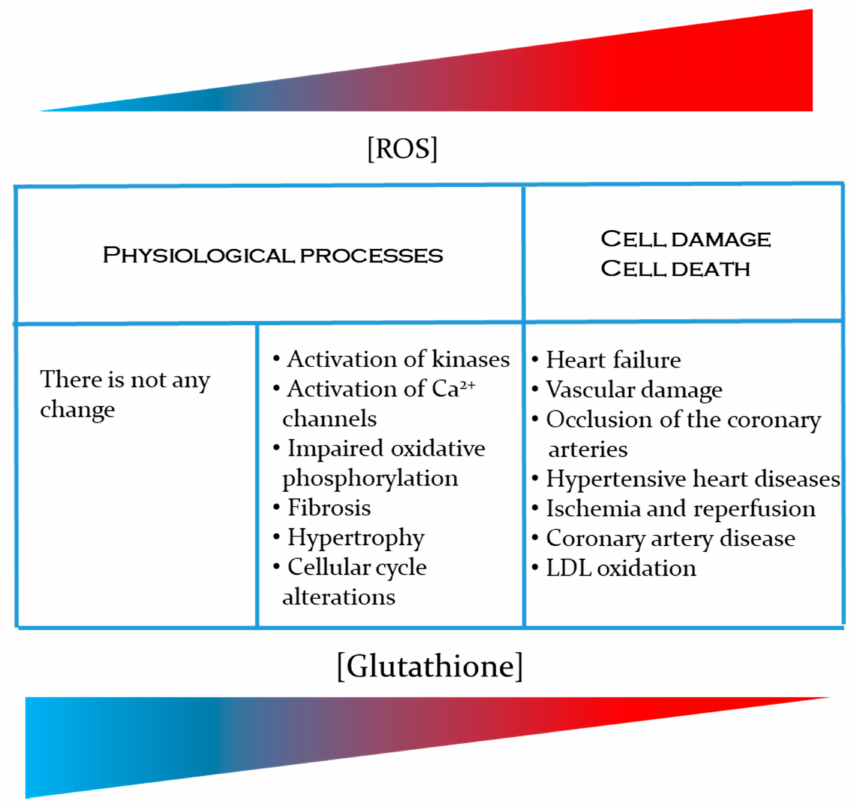
Figure 2. Importance of GSH in the prevention of cardiovascular diseases related to an increase in the production of reactive oxygen species [ROS] and reactive nitrogen species